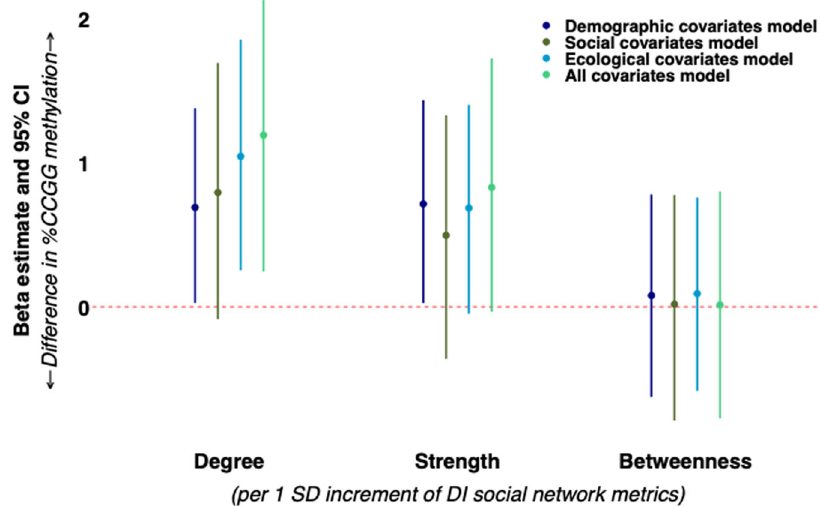
Fig. 3 Associations of hyena DI social network metrics with cub and subadult offspring %CCGG methylation among N = 81 hyenas. All models included a random intercept for maternal ID to account for relatedness, and the offspring ’ s age in months at the time of blood sample collection for DNA methylation quanti fi cation. Models were further adjusted according to four types of covariates (demographic covariates [dark blue], early social experience covariates [dark green], ecological covariates [light blue], and a fully adjusted all covariates model [light green]). 95% CIs were based on percentile bootstrapping (2000 iterations). Source data are provided as a Source Data fi